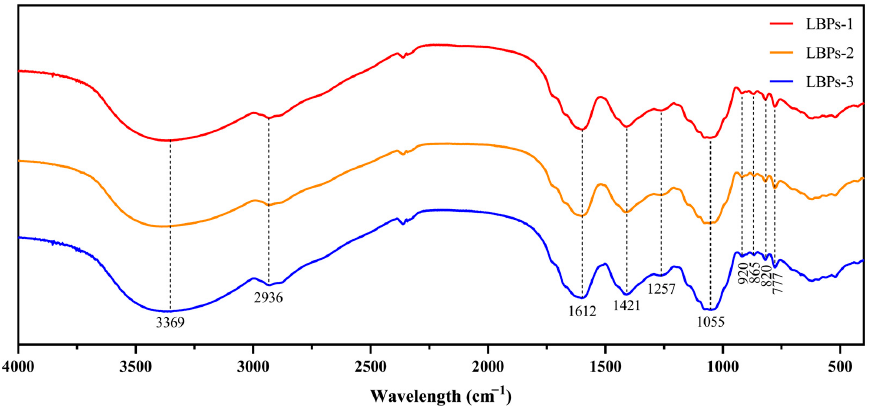
Figure 4. FT-IR spectra of LBPs with three different molecular weights. The Congo red experiment detected whether the polysaccharides had triple-helix conformation. Figure 5A,B depict the λ max and λ max − λ Blank values of the complexes formed between Congo red and LBPs in NaOH solutions of different concentrations. In 0–0.3 M NaOH solutions, LBPs-2 and LBPs-3 exhibited distinct redshifts relative to the